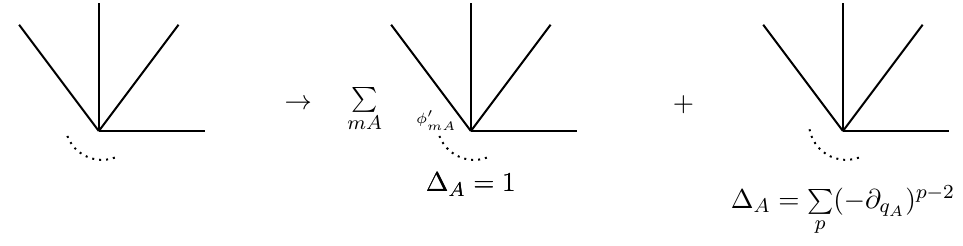
Q ( φ ) where φ denotes massless mode function. ml i ml η 2